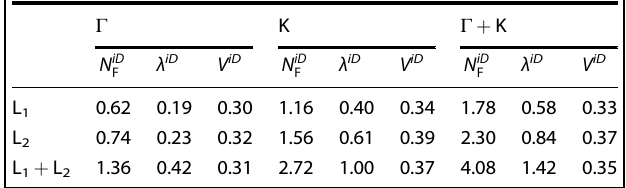
Table 1. Layer and Fermi surface resolved electron – phonon parameters. Layer projections of k -partial integrals of the Fermi DOS ( N